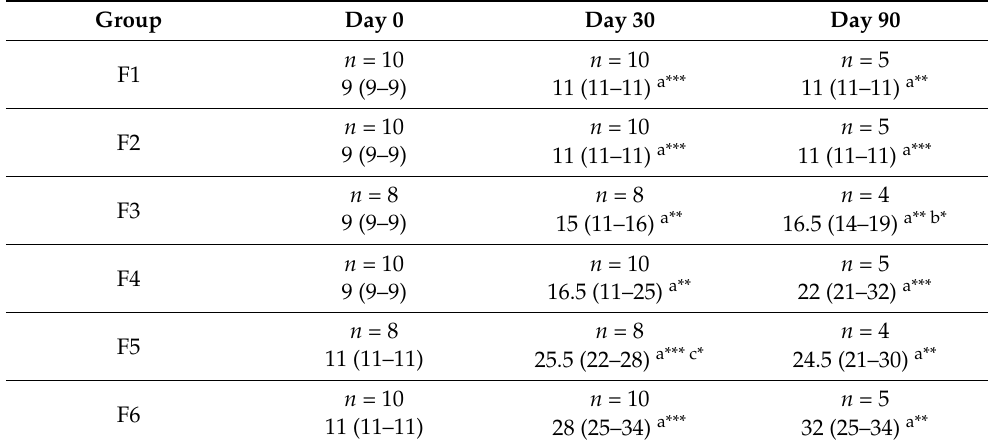
Table 1. Radiological bone healing scores of critical-size segmental femoral defects in rats from the different experimental groups. Data are presented as medians